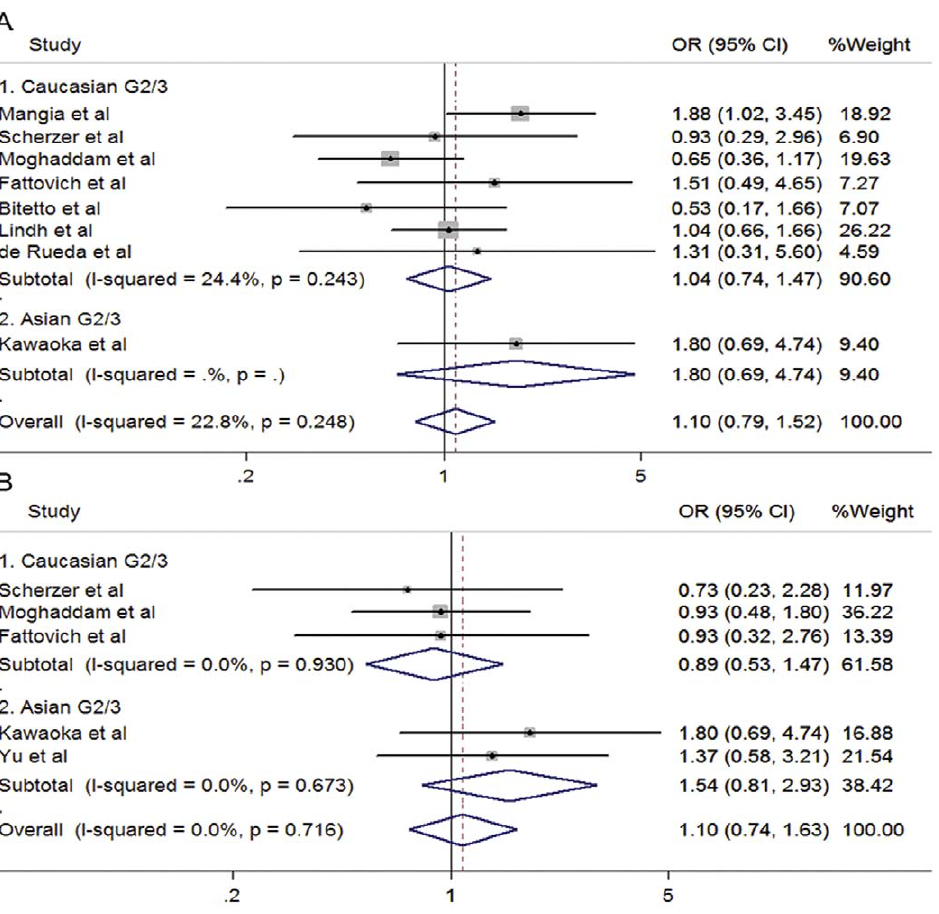
Figure 3. Forrest plots for association between polymorphisms and response to PegIFN/RBV in treatment-naı¨ve HCV G2/3 patients. A. rs12979860 (CC vs CT/TT). B. rs8099917 (TT vs TG/GG).